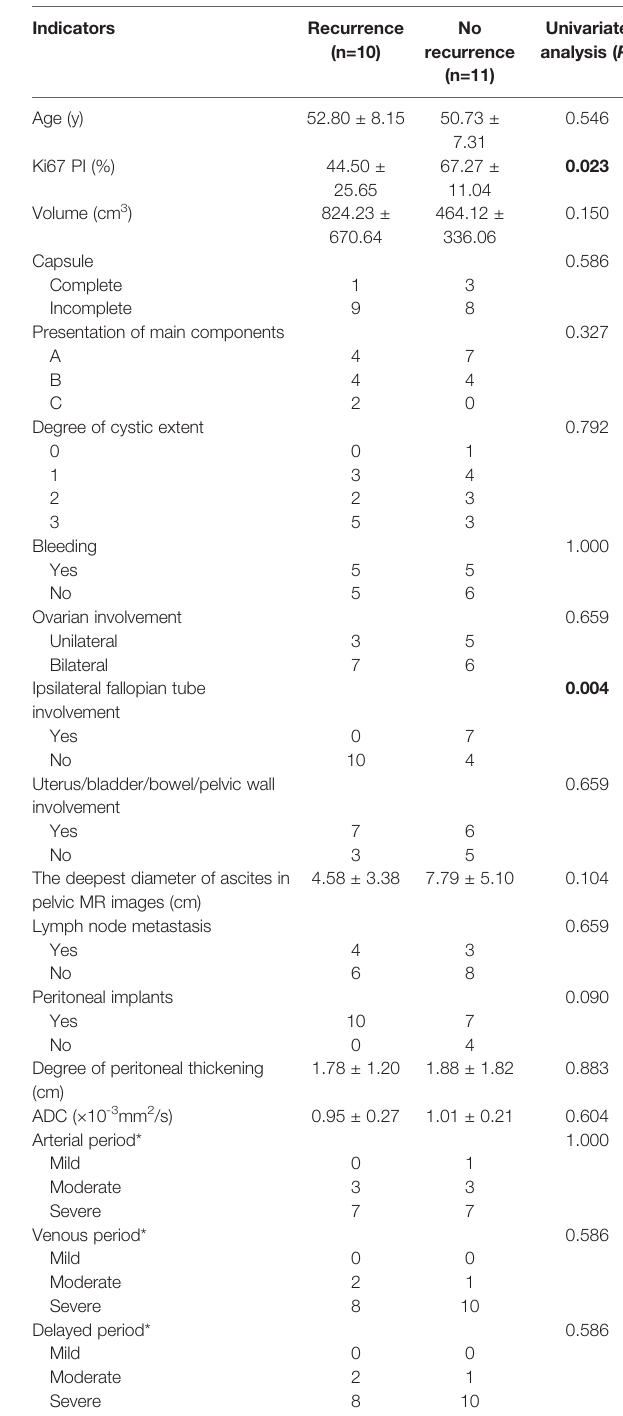
*Enhancement degree. Values in bold are statistically signi fi